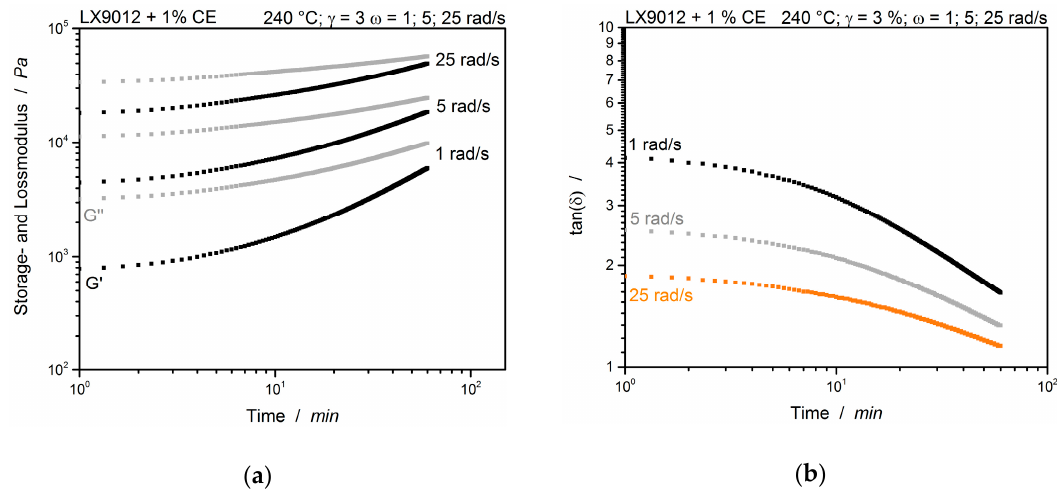
Figure 7. Multiwave test of LX9012 modified with 1% CE measured simultaneous with different frequencies. (a) Storage- and loss modulus and (b) tan( δ ). Measured at 240 °C.